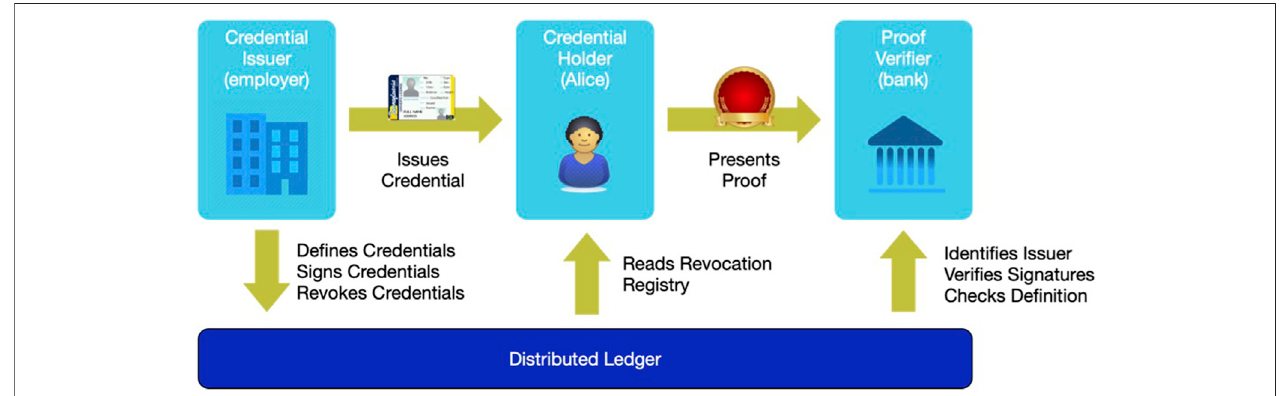
FIGURE 5 | Parties to credential exchange and their interactions with each other and the ledger.